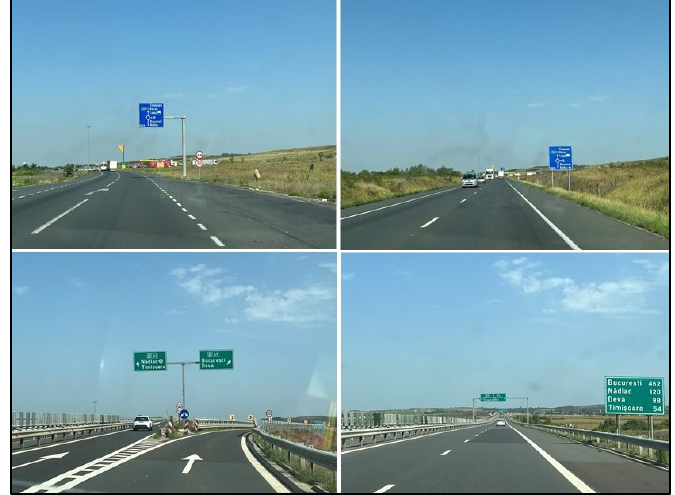
Figure 3 . Images of the new road ring of Lugoj municipality (upper) and of the new highway (lower) connecting the town and Romania with the central and western European countries (photos taken by author, 2022).